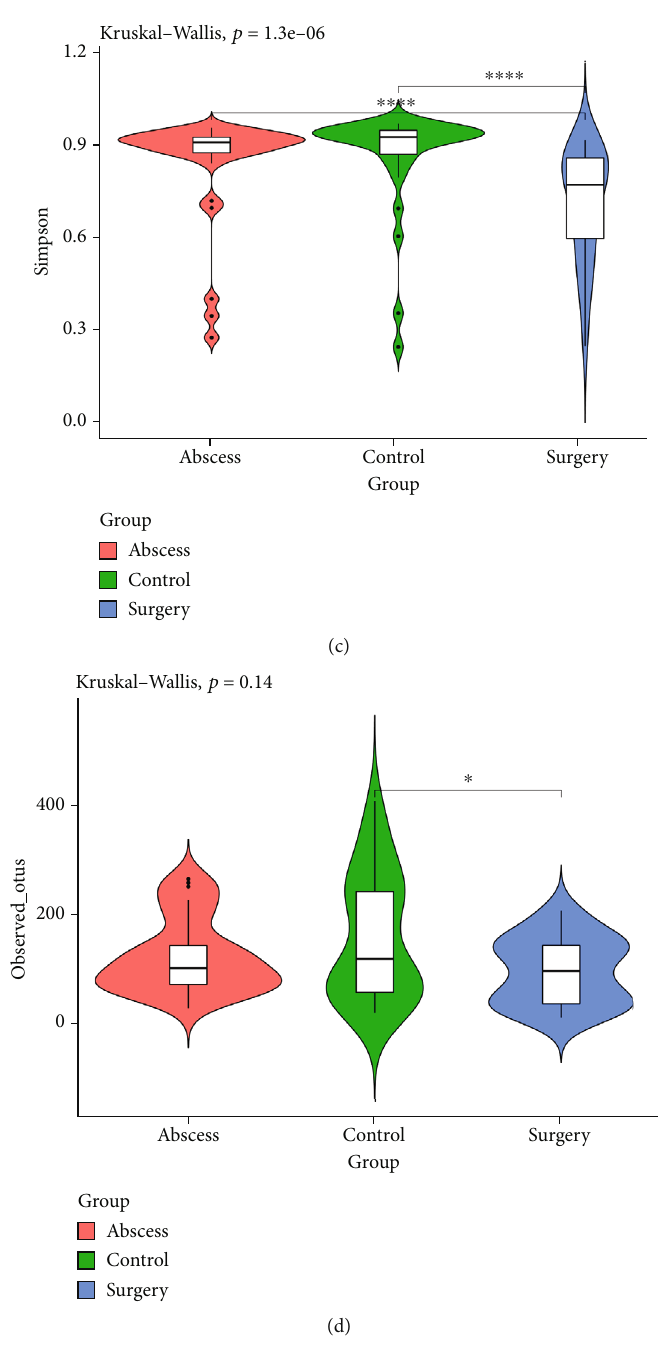
Figure 3: (a) Alpha diversity of gut microbiota diversity estimated by (a) Chao1 index, (b) Shannon index, (c) Simpson index, and (d) observed species index. The p values of the overall di ff erences among the groups were obtained using the Kruskal-Wallis nonparametric test, and the signi fi cance level of the di ff erences was obtained using Dunn ’ s test after pairwise comparison between the groups ( ∗ p < 0 : 05 , ∗∗ p < 0 : 01 , ∗∗∗ p < 0 : 001 ), and ∗∗∗∗ p < 0 : 0001